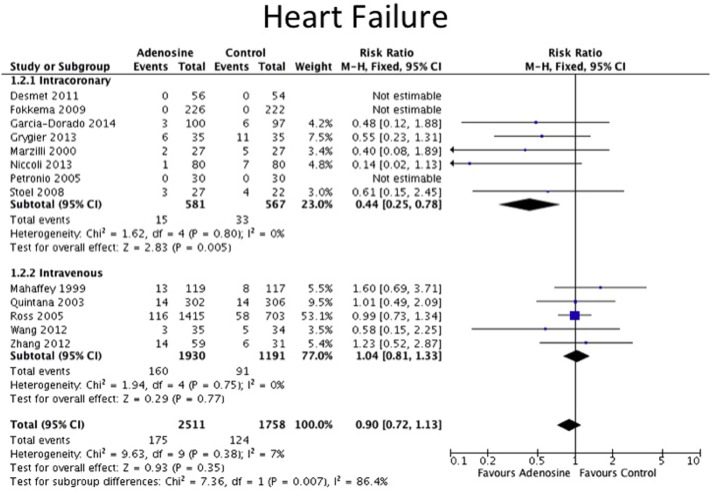
Forest plot for heart failure, adenosine v control.